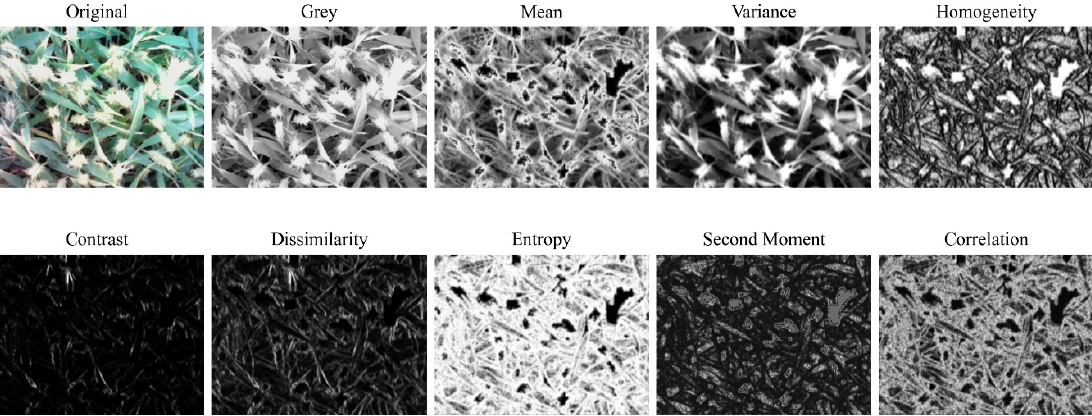
Figure 2. Eight texture feature maps of gray-level co-occurrence matrix from RGB image of wheat canopy in the 0° direction. Table 2. Texture feature calculation formula.